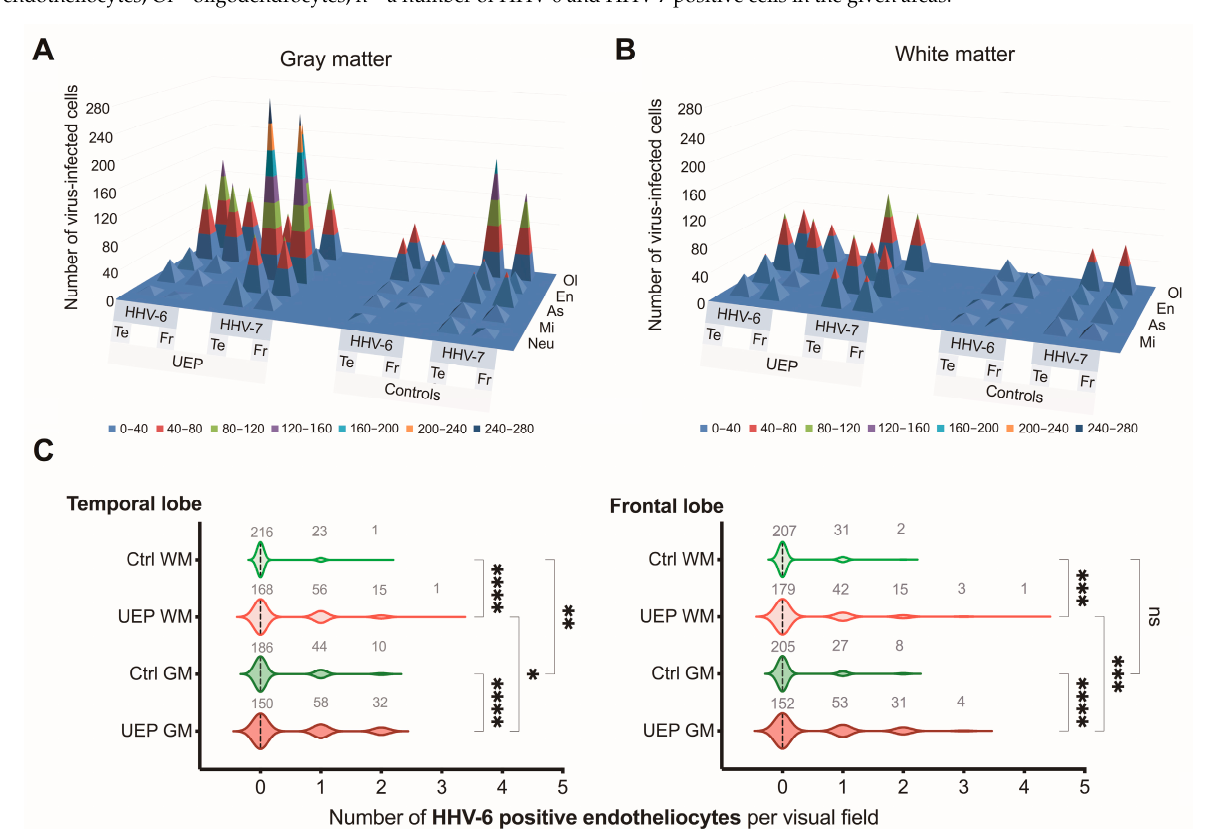
Figure 2. Pyramidal 3D surface and violin plots representing the data of brain tissue immunohistochemical (IHC) analysis: ( A ) total numbers of herpesvirus-6, -7 (HHV-6, -7) positive Neu (neurons), As (astrocytes), Ol (oligodendrocytes), Mi (microglia), En (endotheliocytes) in the gray matter of the unspecified encephalopathy (UEP) group and controls, frontal lobe (FR), temporal lobe (Te); ( B ) total numbers of HHV-6, -7 positive As (astrocytes), Ol (oligodendrocytes), Mi (microglia), En (endotheliocytes) in the white matter of the UEP group and controls, frontal lobe (FR), temporal lobe (Te); ( C ) distribution of total HHV-6 immunopositive endothelial cells per visual fields in the white (WM) and gray matter (GM) of the control (Ctrl) and UEP group in the temporal and frontal lobe. The blue plane represents a zero level (no virus-infected cells in the visual fields). Violin plots: dashed lines represent the approximate ratio of visual fields (out of 240) with HHV-6 positive endotheliocytes to fields with HHV negative cells (“0”— ratio less than 1.0, “1”— more than 1.0); numbers in gray show visual fields; asterisks represent a significance level (* p < 0.05, ** p < 0.01, *** p < 0.001, **** p < 0.0001) between group differences (Kruskal-Wallis test